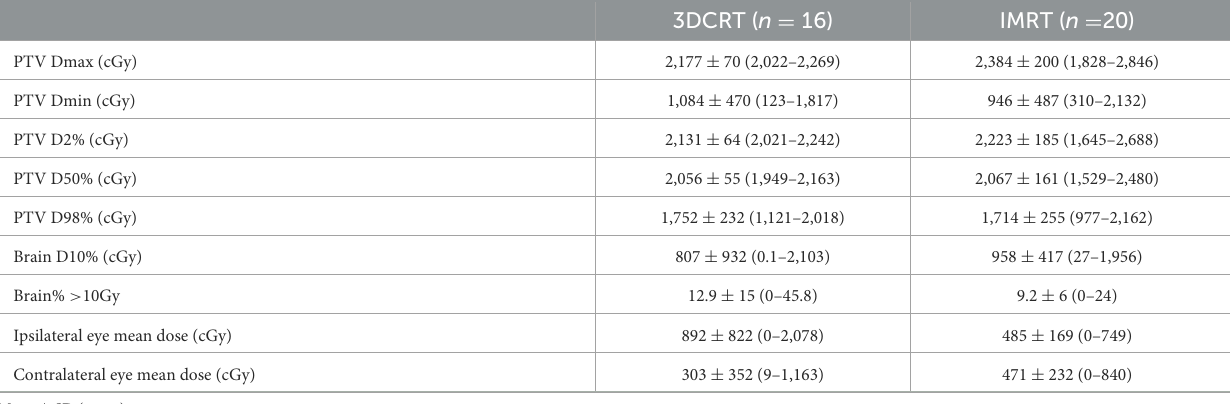
TABLE 1 Dose-volume histogram data between 3DCRT and IMRT plans.